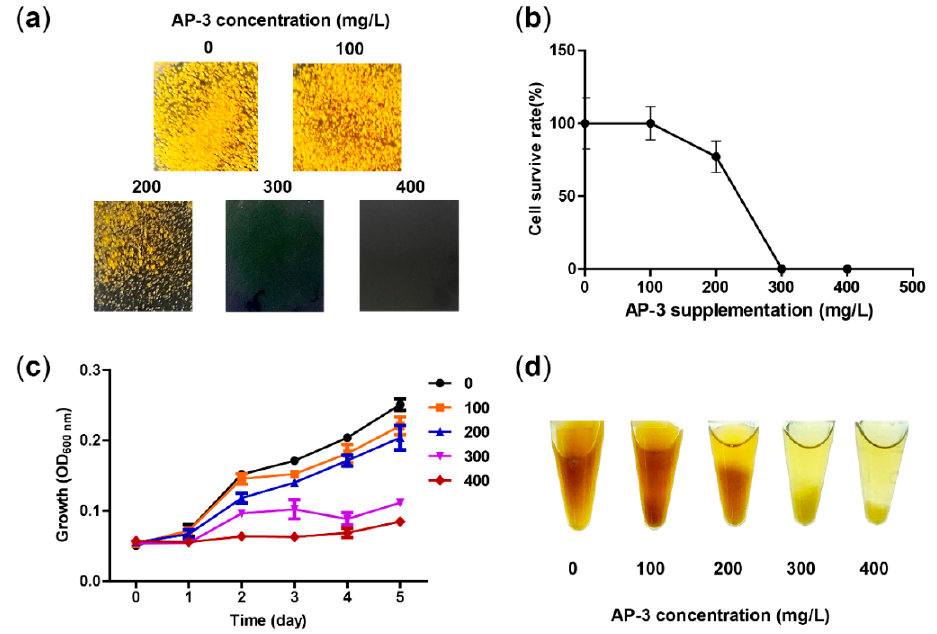
Figure 1. Resistance and growth of A. pretiosum WXR-24 under di ff erent concentrations of AP-3. ( a ) Growth of A. pretiosum WXR-24 on YMG plates containing 0, 100, 200, 300 or 400 mg / L AP-3. The photos were taken on day 3 after inoculation. ( b ) Survive rate (%) of WXR-24 on YMG plates containing 0, 100, 200, 300 or 400 mg / L AP-3. The survive rate of the plates supplemented without AP-3 was set as 100%, and the values on other plates were accordingly calculated. Mean values of three independent experiments are shown with SD indicated by error bars. ( c ) Growth of A. pretiosum WXR-24 in fermentation broths containing 0, 100, 200, 300 or 400 mg / L AP-3. Mean values of three independent experiments are shown with SD indicated by error bars. ( d ) The cultures of A. pretiosum WXR-24 on day 5 after inoculation. Less mycelia are observed in fermentation broths containing 200–400 mg / L AP-3.